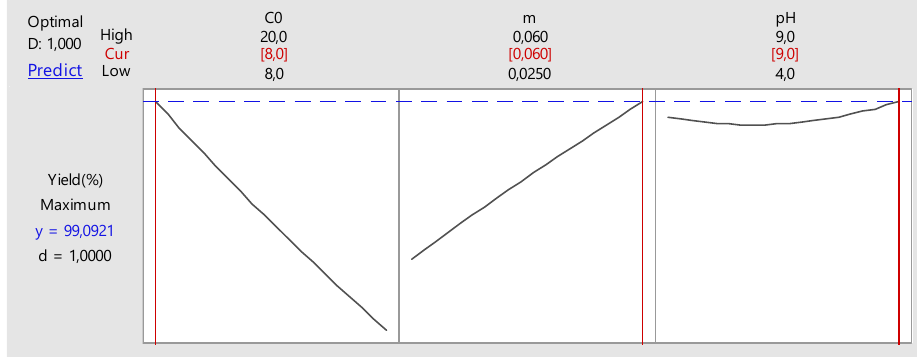
Figure 10. Diagrammatic optimization of MB removal parameters.